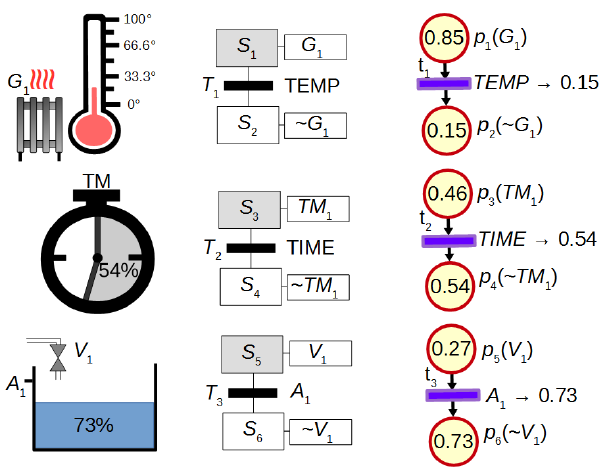
Figure 2. The advantage of FIPN visualization in comparison to discrete